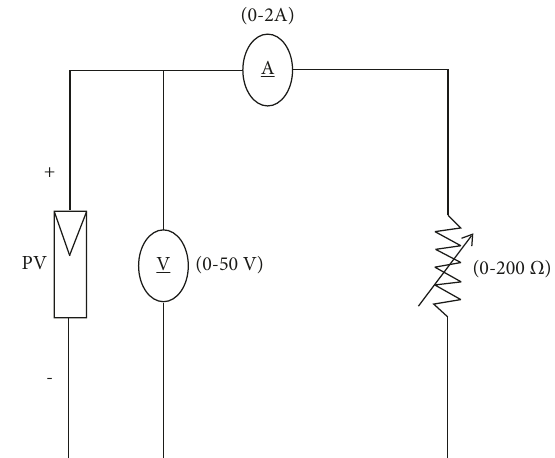
Figure 4: V-I characteristics for polycrystalline and monocrys- talline lunar